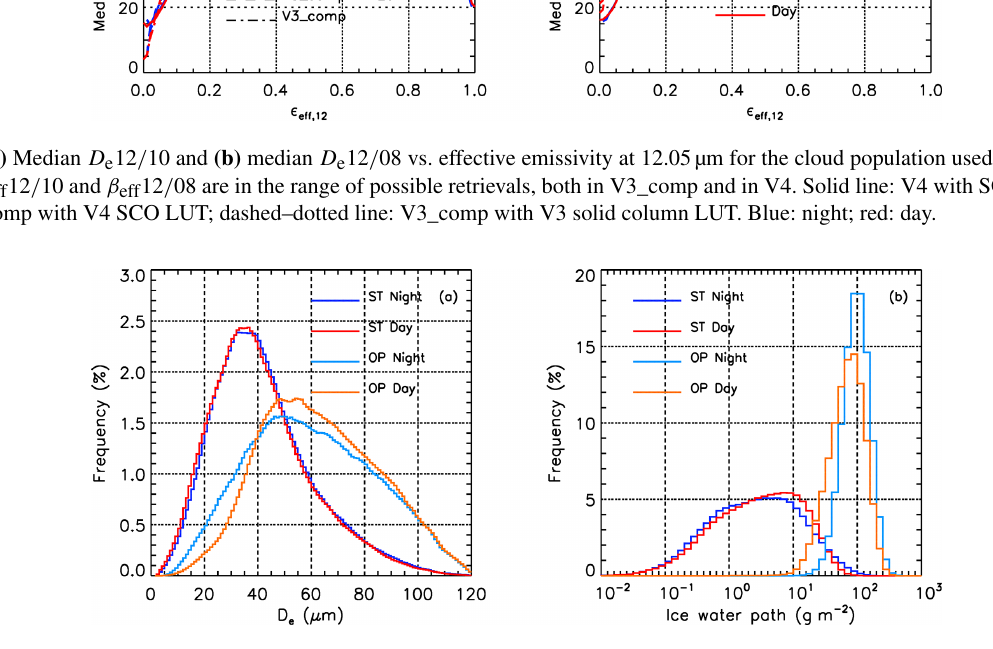
Figure 8. Histograms of V4 confident retrievals of (a) D e and (b) ice water path in single-layered semi-transparent (ST; night: navy blue; day: red) and opaque (OP; night: light blue; day: orange) ice clouds between 60 ◦ S and 60 ◦ N over oceans in January 2008.